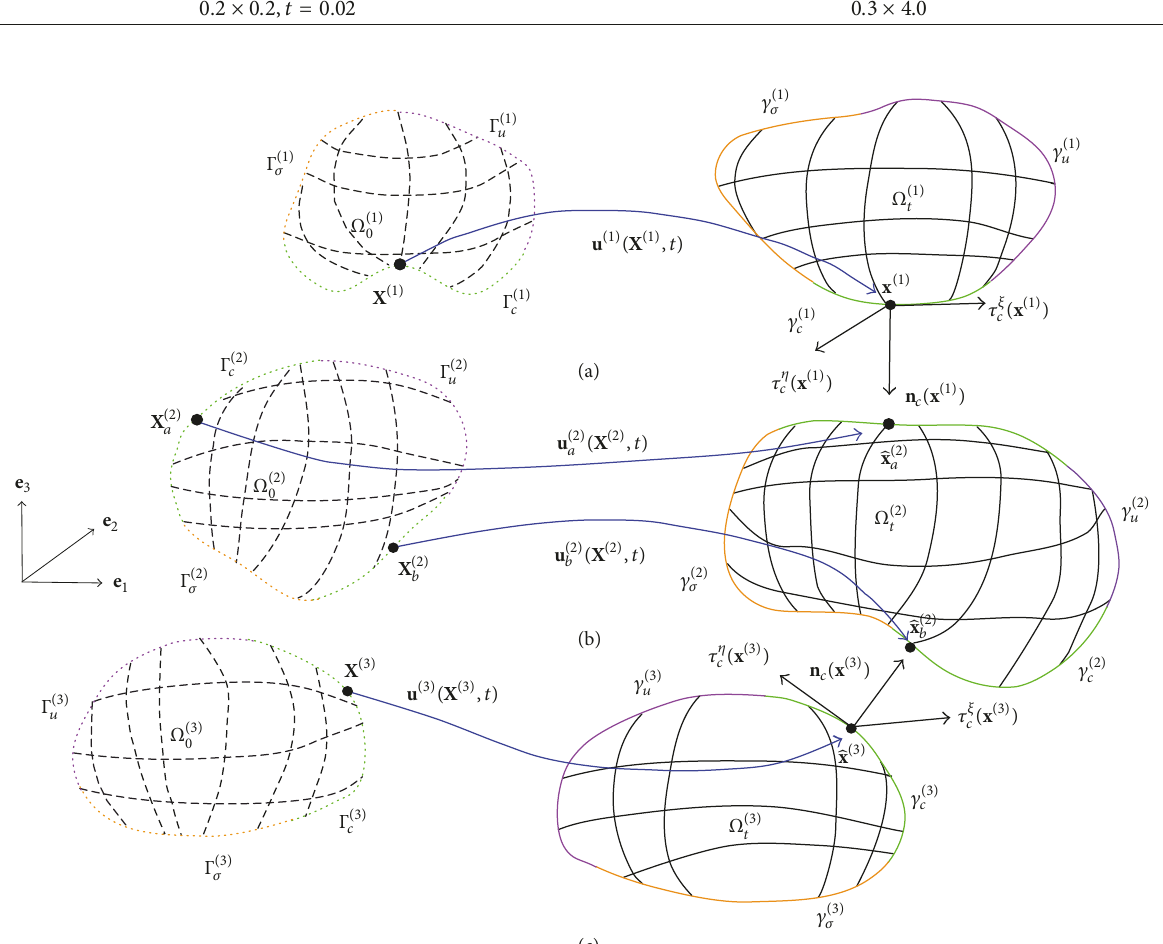
Figure 1: Kinematics of a multiple pounding problem.